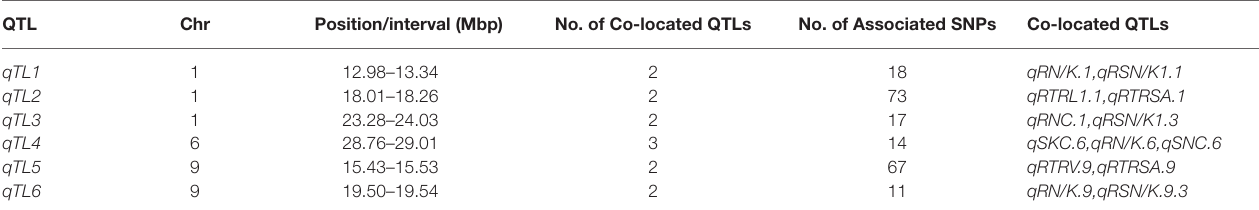
TABLE 1 | Co-localization of QTLs at seeding